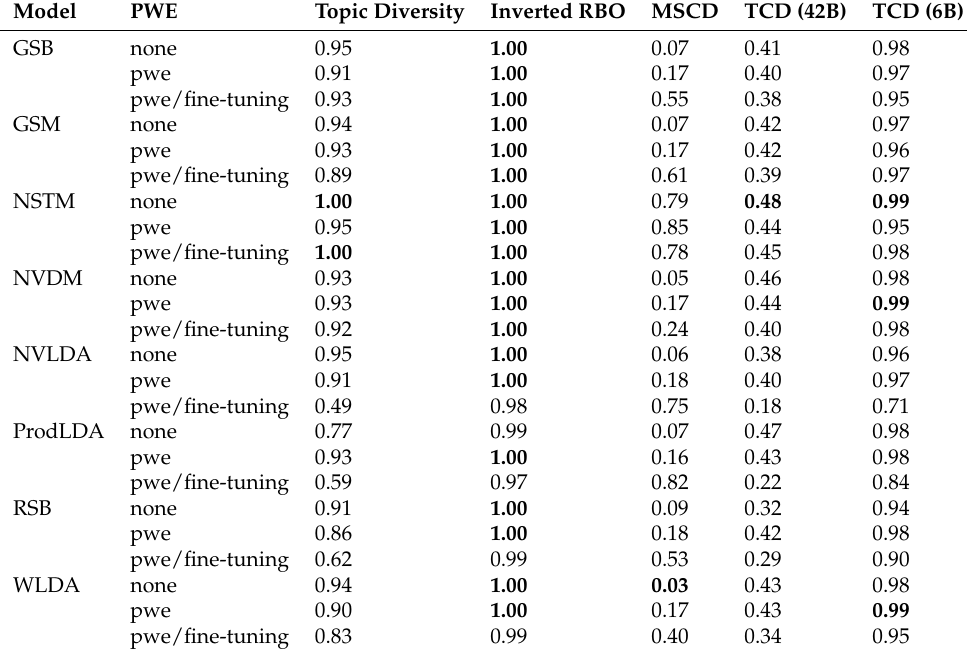
Table 19. Topic Diversity on